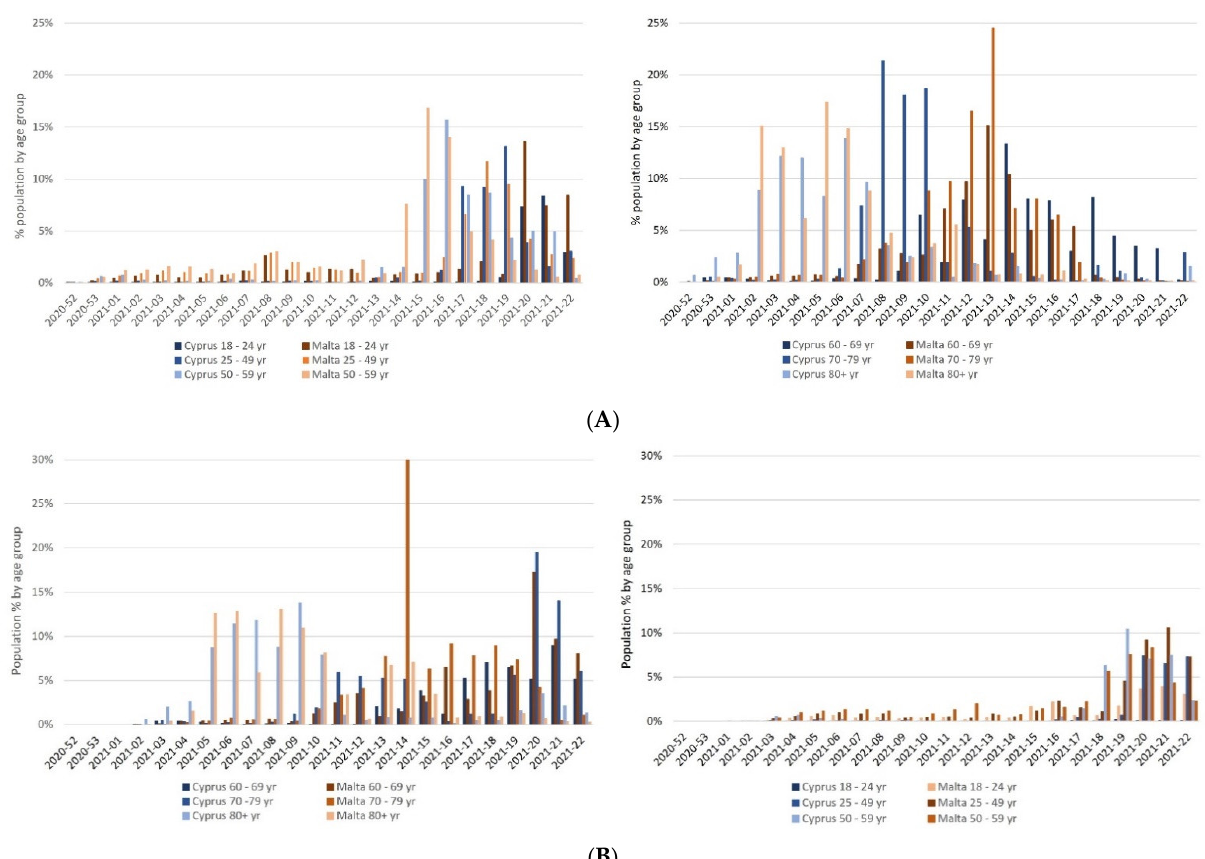
Figure 3. ( A ) Comparative assessment of the weekly first dose vaccination coverage by age groups in Cyprus and Malta. ( B ) Comparative assessment of the weekly full vaccination coverage by age groups in Cyprus and